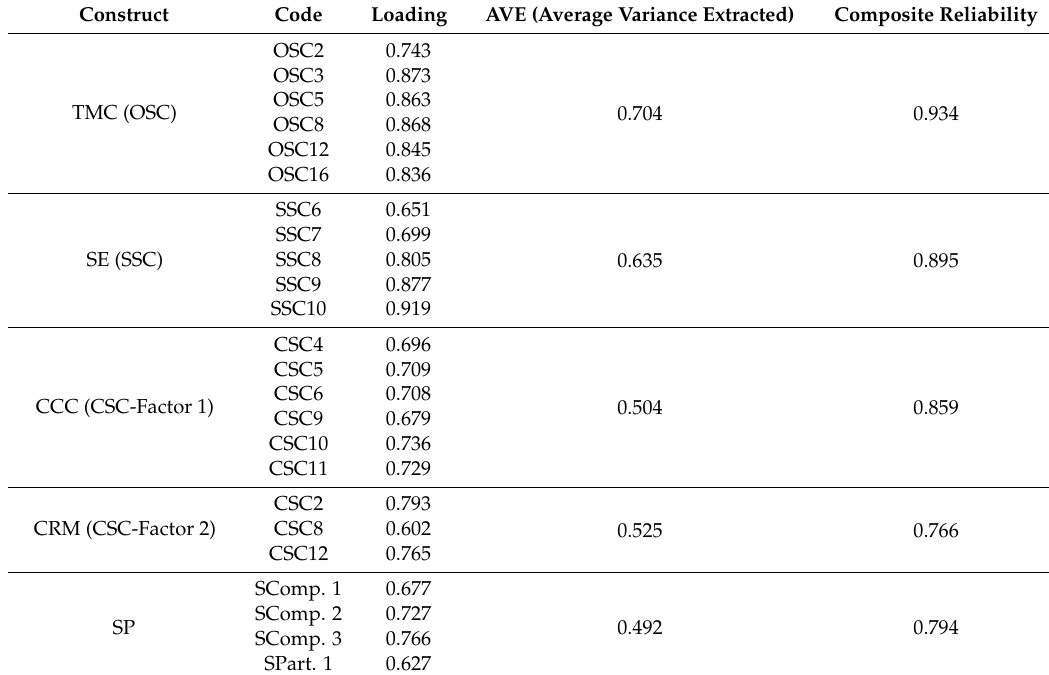
Table 3. Measurement model evaluation.